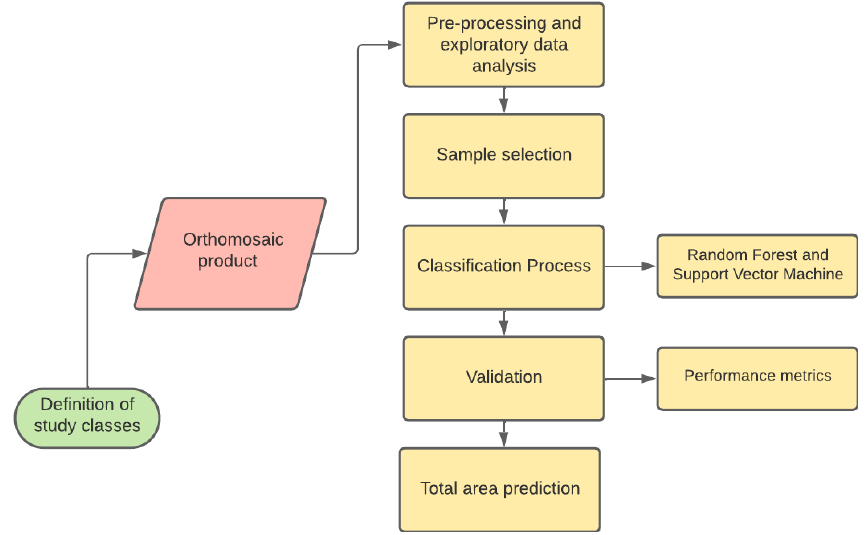
Figure 4. Flowchart of the classification process with the methodological steps used.